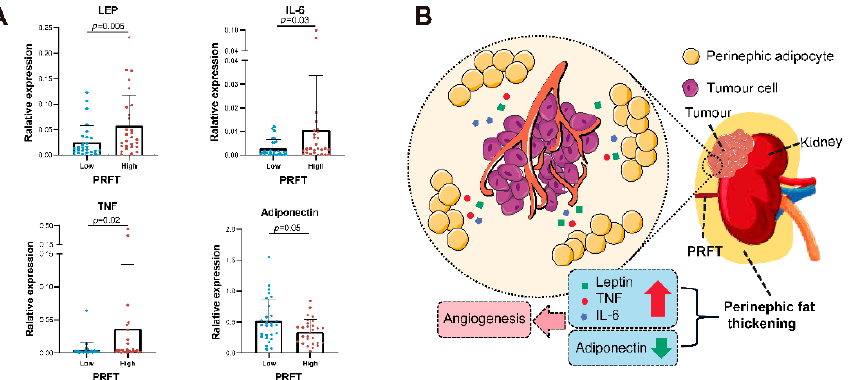
Figure 5. Potential mechanisms of perirenal fat in predicting patient clinical outcomes. Perirenal fat was collected from fifty-six patients for qPCR. We found the genes of leptin, IL-6 and TNF were highly expressed in patients with high PRFT, while low expression of adiponectin gene was showed ( A ). The possible patterns were mapped based on relevant literature and results ( B ). IL-6: interleukin-6; PRFT: perirenal fat thickness; qPCR: quantitative polymerase chain reaction; RCC: renal-cell-carcinoma; TNF: tumor necrosis factor.